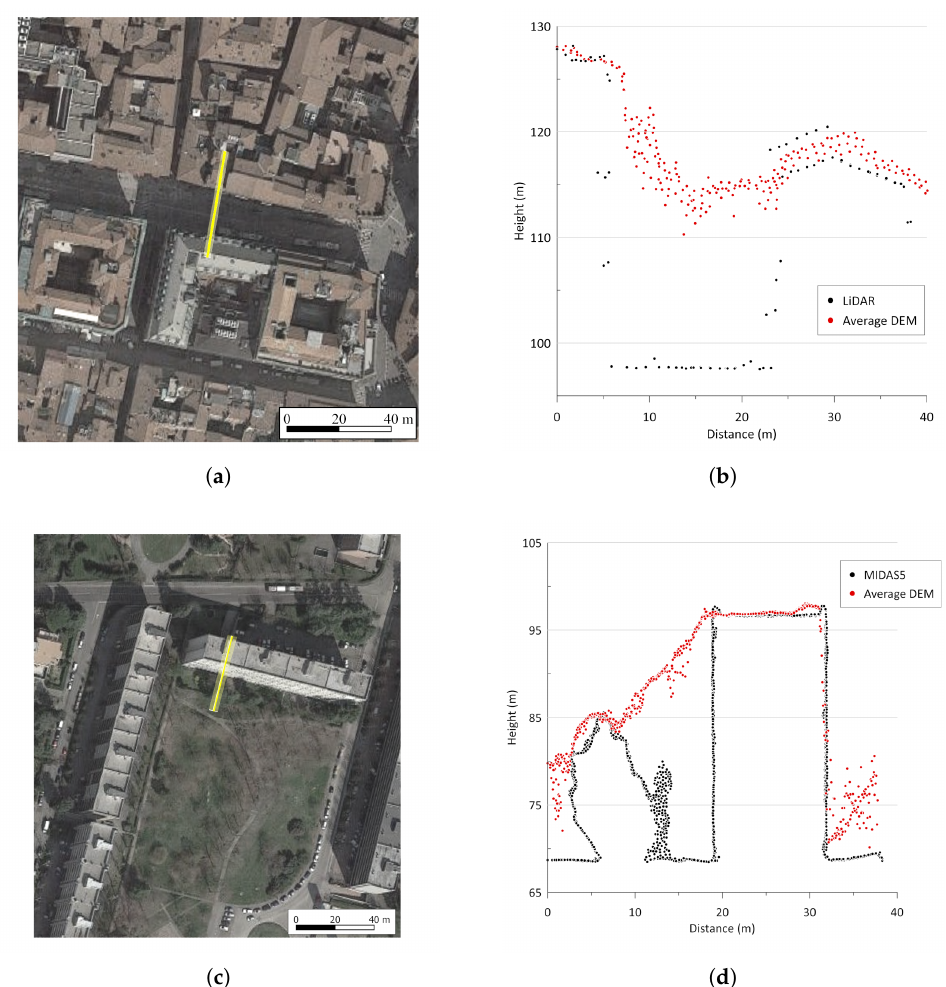
Figure 9. Sections of the point clouds extracted in the Centre area ( a , b ) and in Corticella area ( c , d ), respectively. A buffer of 1.5 m was considered to select